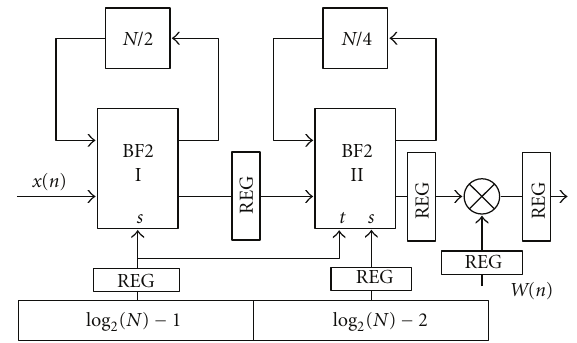
Figure 10: Adding pipeline registers for R2 2 SDF.